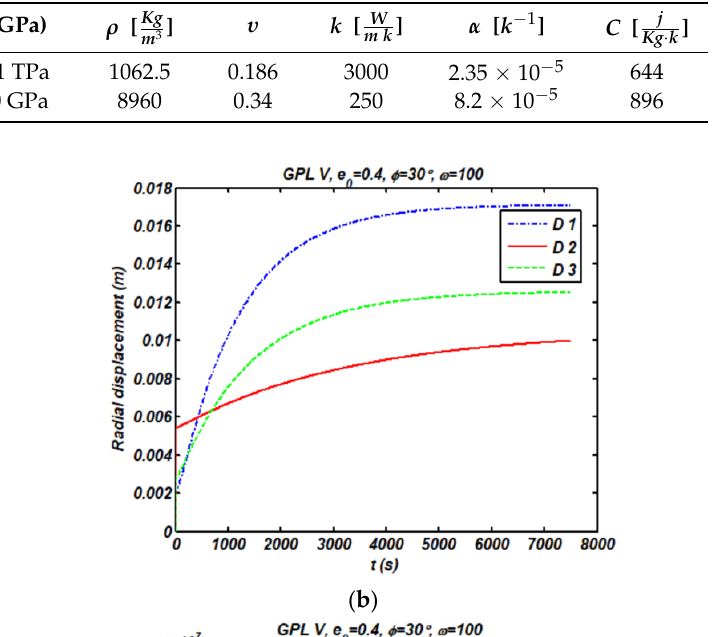
Table 1. Material property of metal matrix and GPLs. Figure 3. Influence of GPL pattern on the transient temperature ( a ), radial displacement ( b ), and stress state ( c – f ) for a center point of truncated cone (D1; 0 e = 0.4; 100 rad/s).